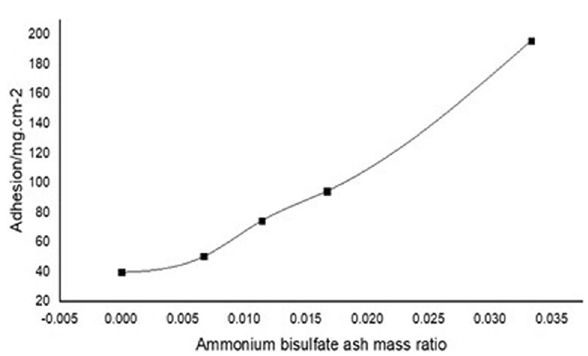
Figure 6. Change curve of fly ash adhesion under different ammonium bisulfate content 37